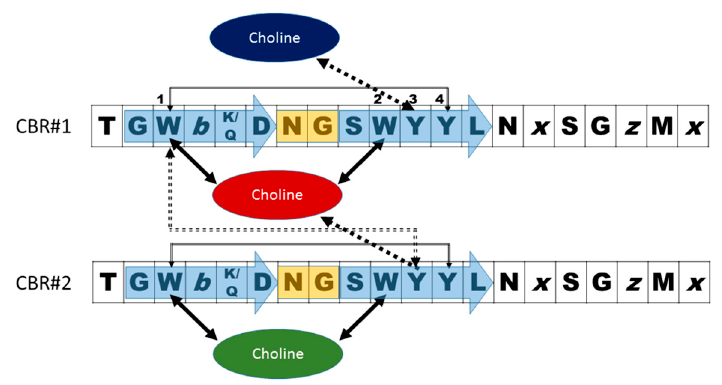
Figure 3. Scheme of a standard pneumococcal choline-binding site configured by two consecutive CBRs with the consensus sequence deduced by Jalview [71,72]. b is a hydrophobic residue, z has a small side chain and x may be any residue. The blue arrows and orange rectangle indicate the strand-turn-strand configuration of the β -hairpin. Black, solid arrows show the cation- π interactions with choline. Grey arrows indicate stabilizing π - π stacking between aromatic side chains. Dashed arrows denote a contact that may be found either as cation- π or π - π types. Numbers indicate the situation of aromatic residues in the repeat.